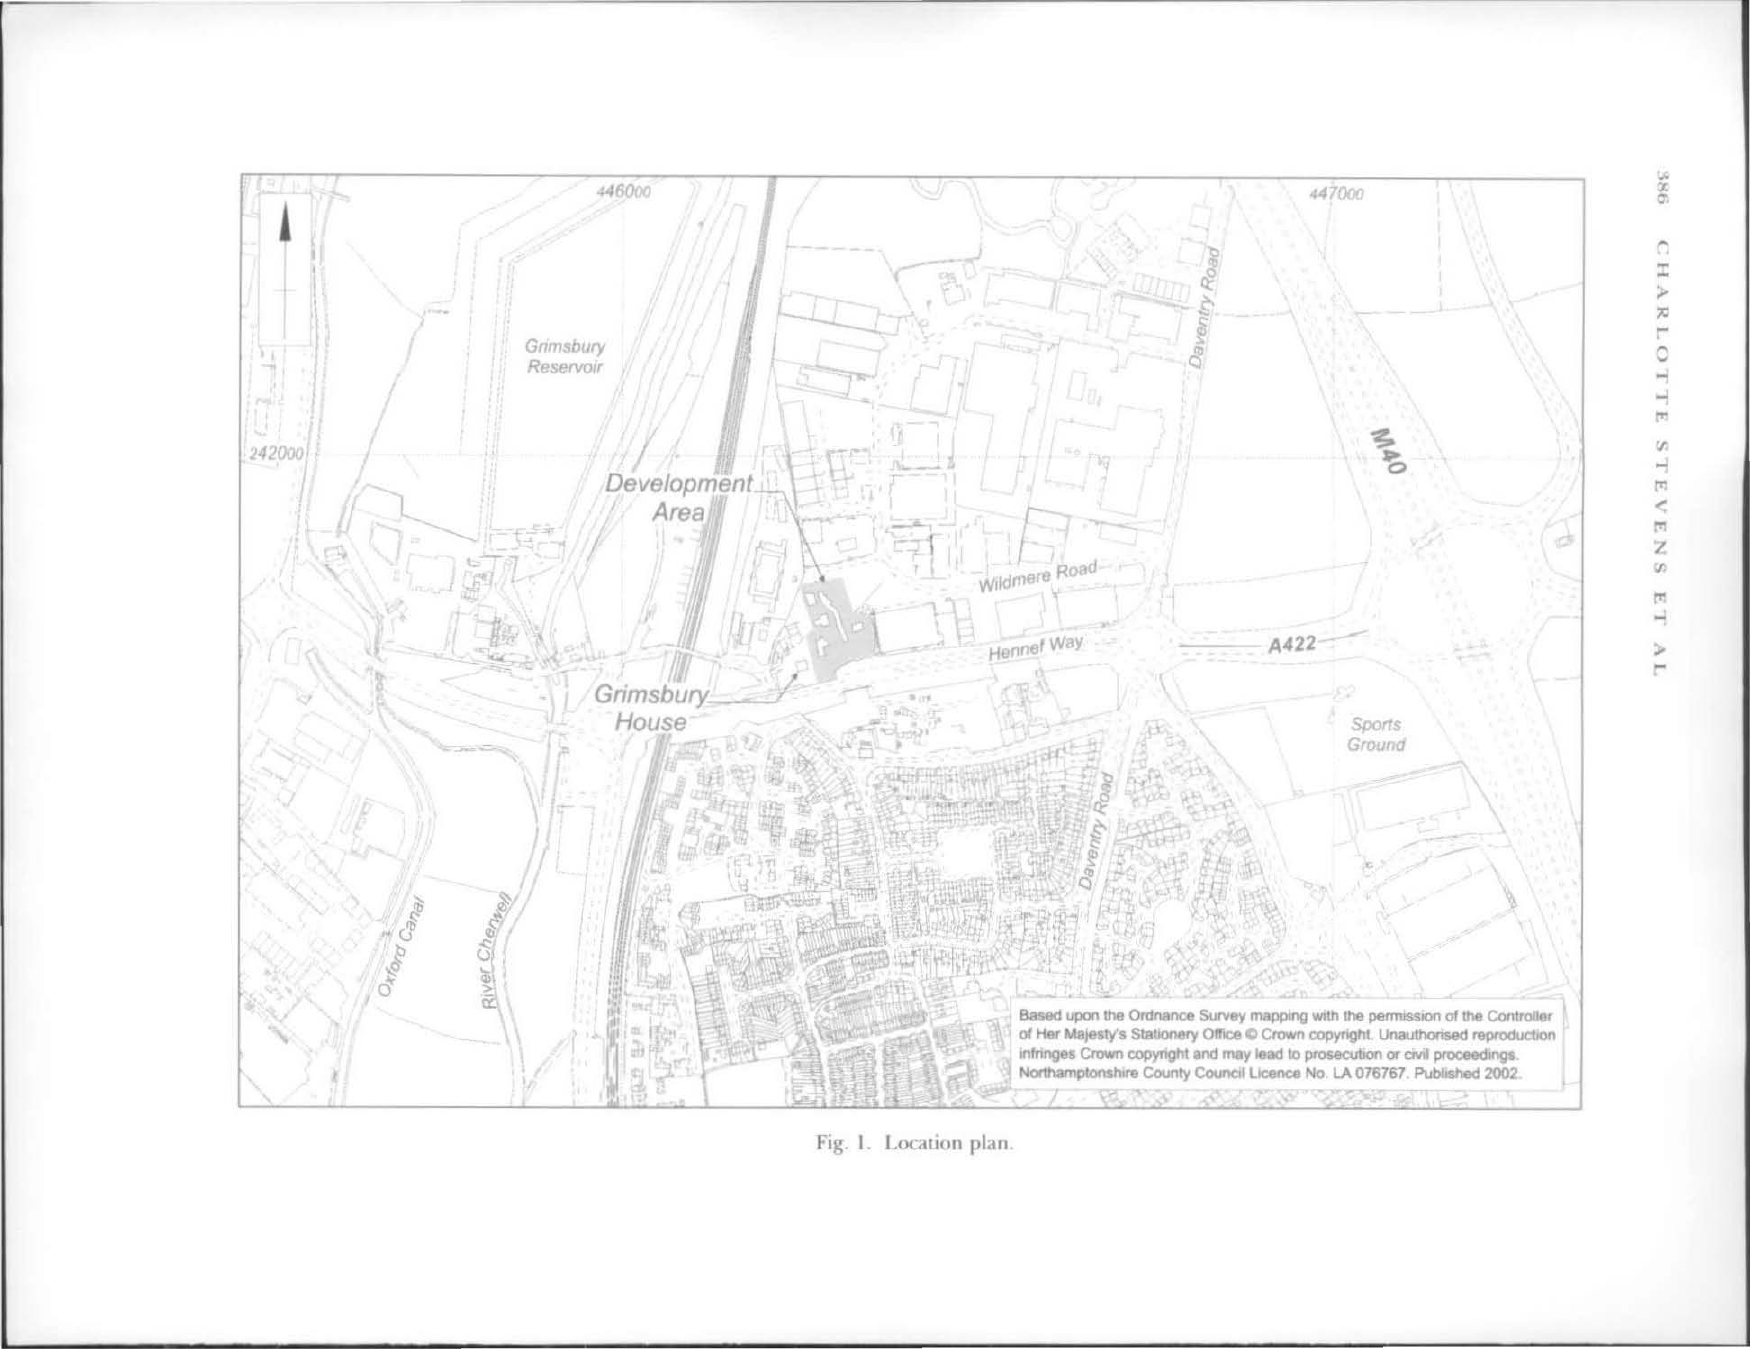
Based upon the 0rdnen0I Survey mapping WIth the perm!S&Or'I of ItMt Conlrohr of Her MajeSty's Stauonety 0fII0t C Crown oop)'fIghl lJnaIthonsed ~ 1nfnnge8 Crown ~ and lTIIy lead 10 prOMCUbon or aY1I PI oceedIIlQ. ~ County CouncIl ~ No LA 076767. PutIiehed 2002 7 Fig. I Locauon plan